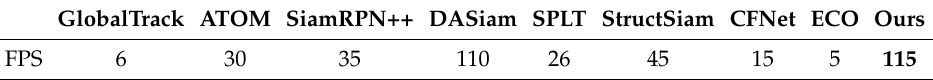
Table 4. Computational costs of visual trackers in terms of frames per seconds